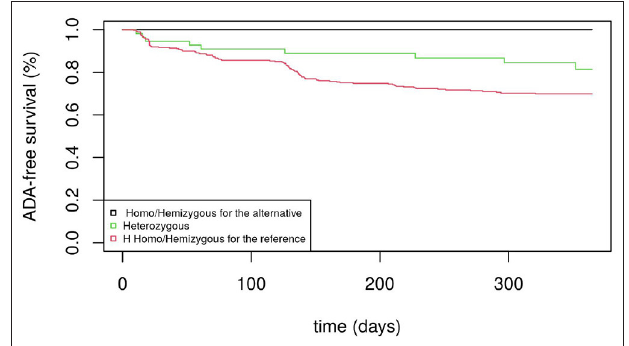
FIGURE 1 | ADA-free survival curves (men and women) for rs5991366.